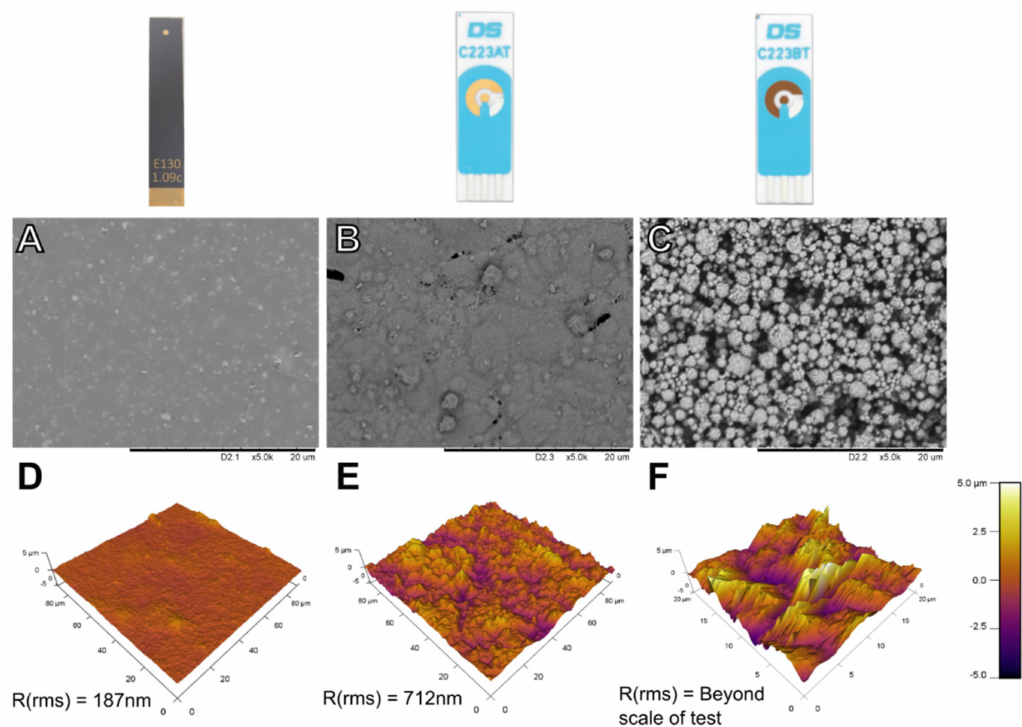
Figure 3. Microscopy images of different electrode types. Scanning electron microscopy images of ( A ) thin-film gold electrode, ( B ) AT and ( C ) BT screen-printed electrodes. Atomic force microscope surface topography scans of ( D ) thin-film gold electrode, ( E ) AT SPE and ( F ) BT SPE, with median R rms from 5 different areas